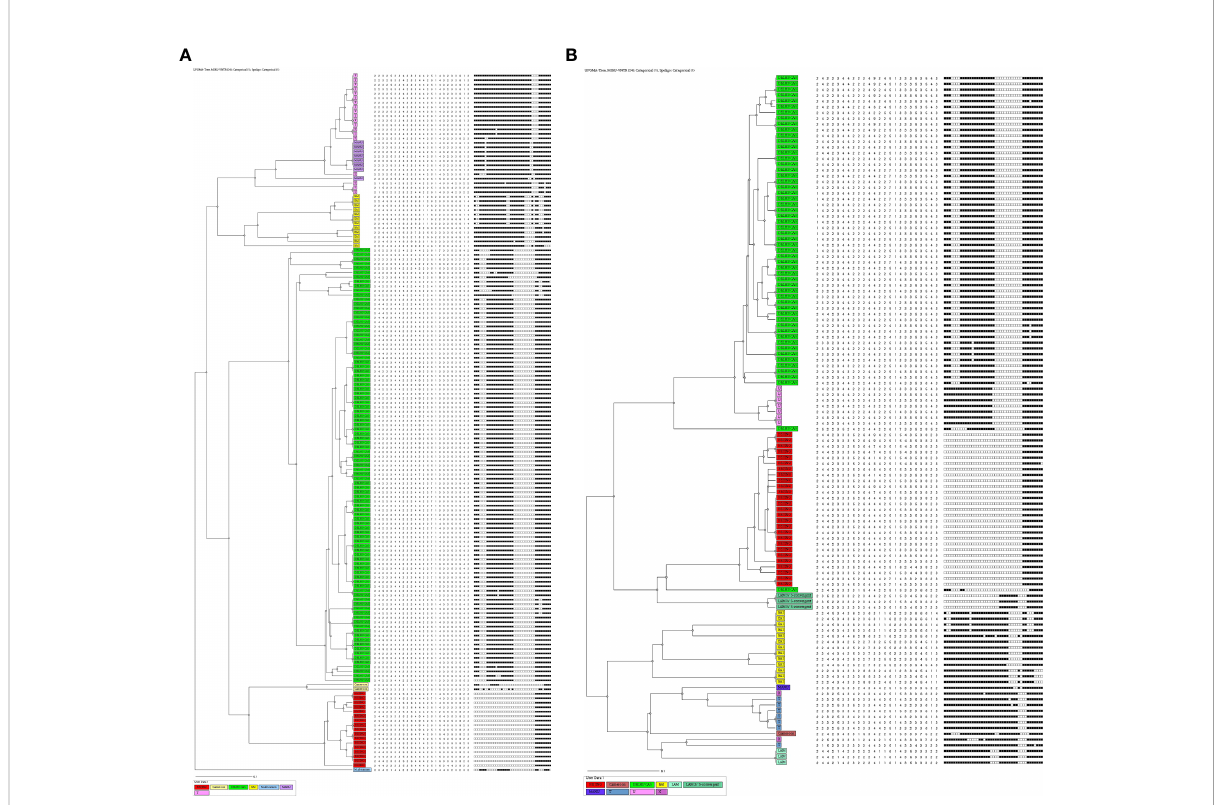
FIGURE 1 (A) UPGMA-dendrogram representing MIRU-VNTR and spoligotype patterns of 156 isolates from HIV-negative cases. (B) UPGMA-dendrogram representing MIRU-VNTR and spoligotype patterns of 120 isolates from HIV Positive